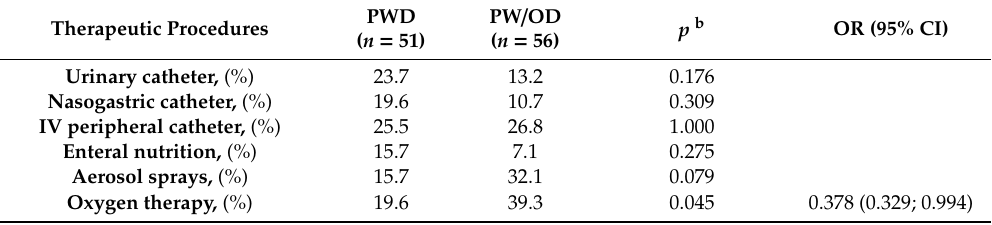
Table 6. Comparison of therapeutic procedures in patients of NH with dementia (PWD) and without dementia (PW /